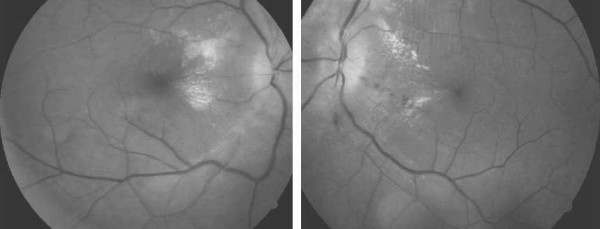
Fundus photograph of right and left eye depicting bilateral neuroretinitis.